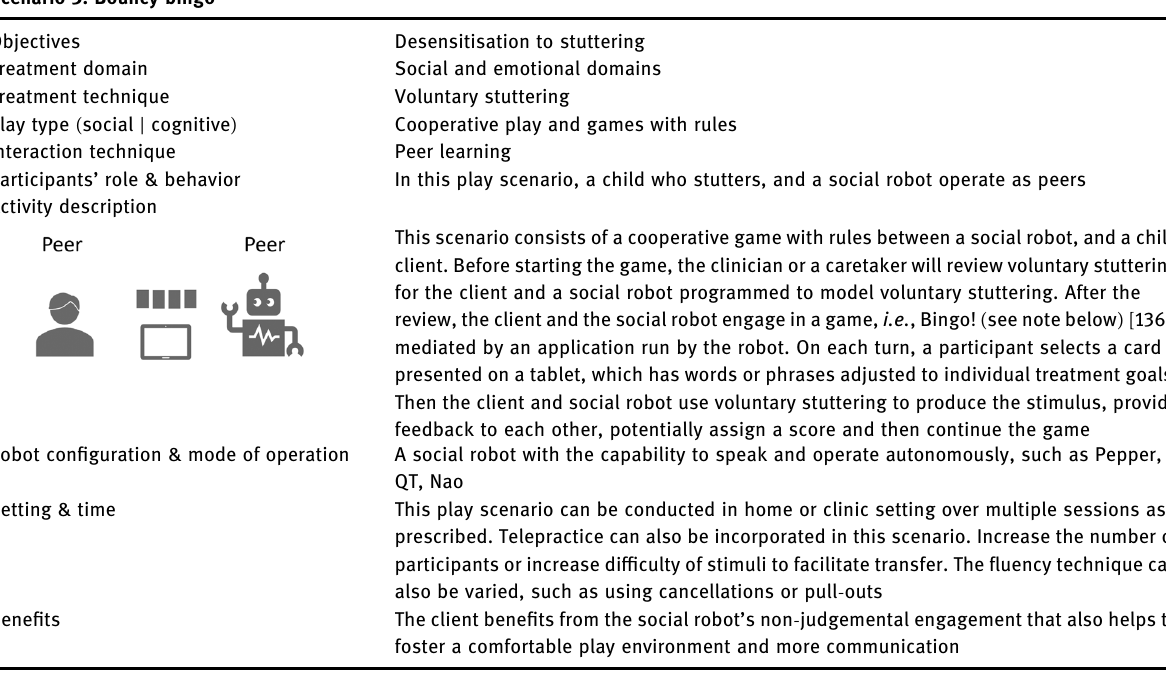
Table 3: Description of scenario 3